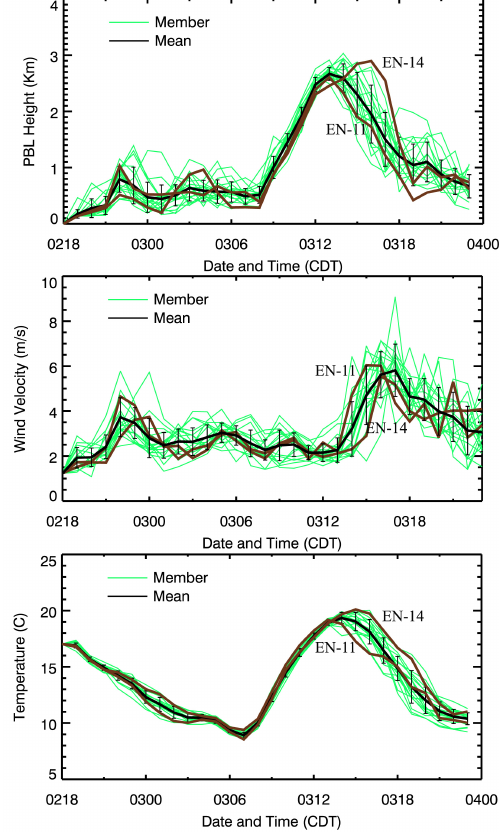
Fig. 10. Temporal evolution of the PBL height (km, top panel), wind speed (m/s, middle panel), and surface temperature ( ◦ C, bot- tom panel) from each ensemble member (thin green lines) and en- semble mean (bold black line) of the CTRL ensemble simulation (3 March 2006), two bold orange lines indicate two extreme members (EN-11 and EN-14).